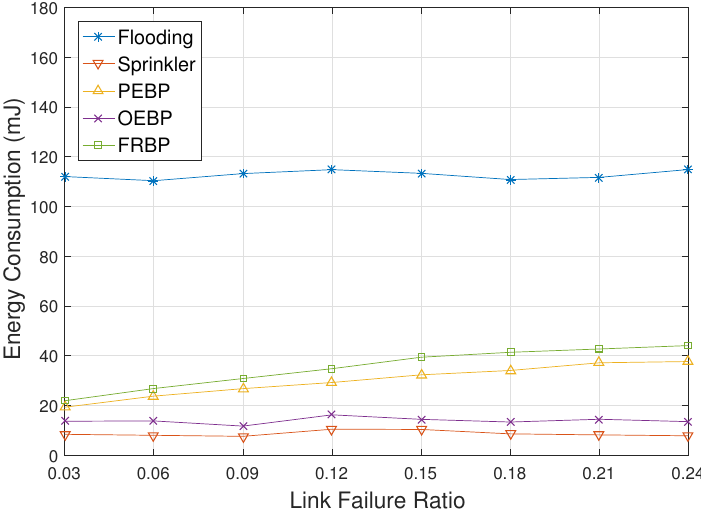
Figure 11. Average energy consumption impacted by the link failure